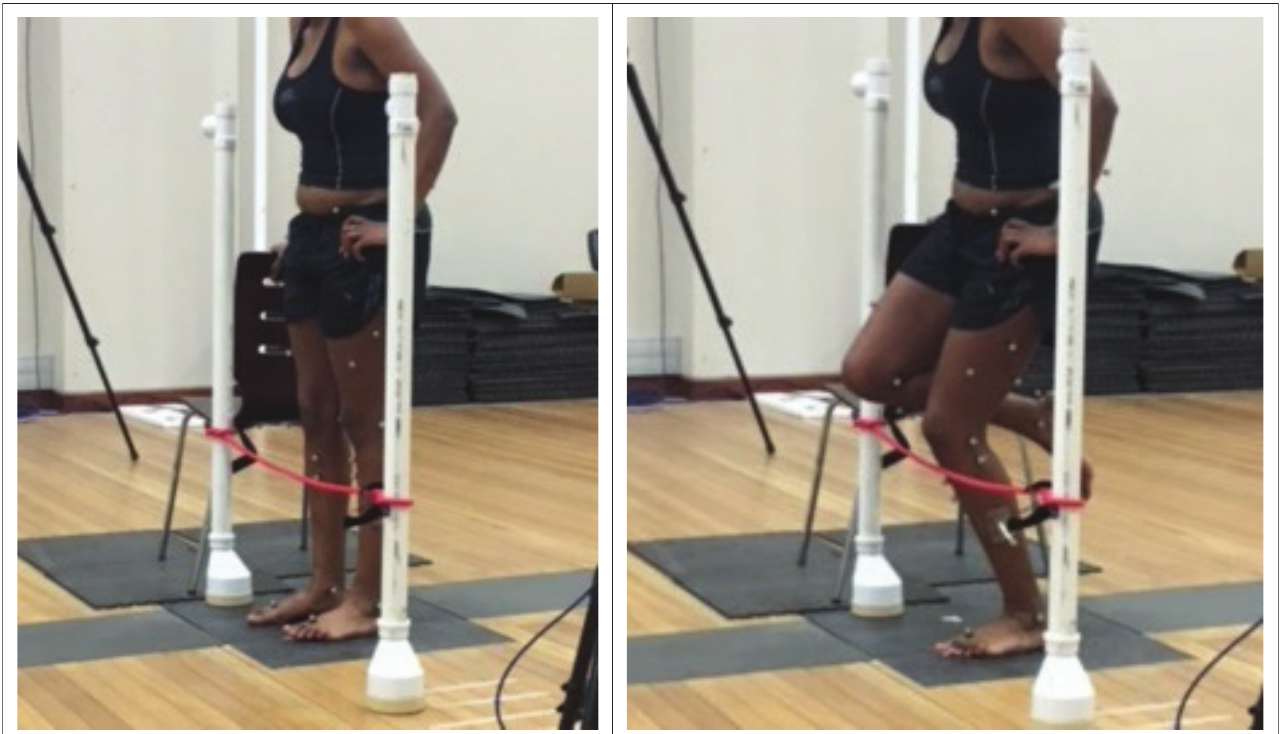
FIGURE 2: Single leg squat in standing to measure weightbearing joint position